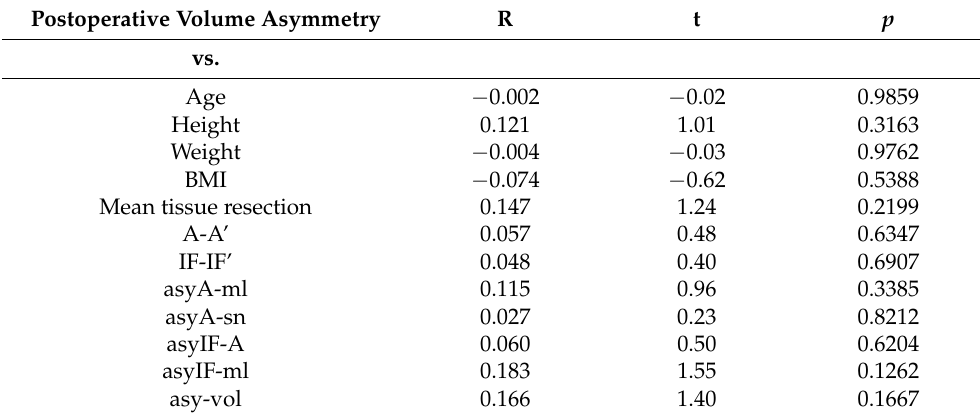
Table 4. Relationship between the postoperative volume asymmetry (6 months after breast reduction) and clinical and preoperative metric variables.